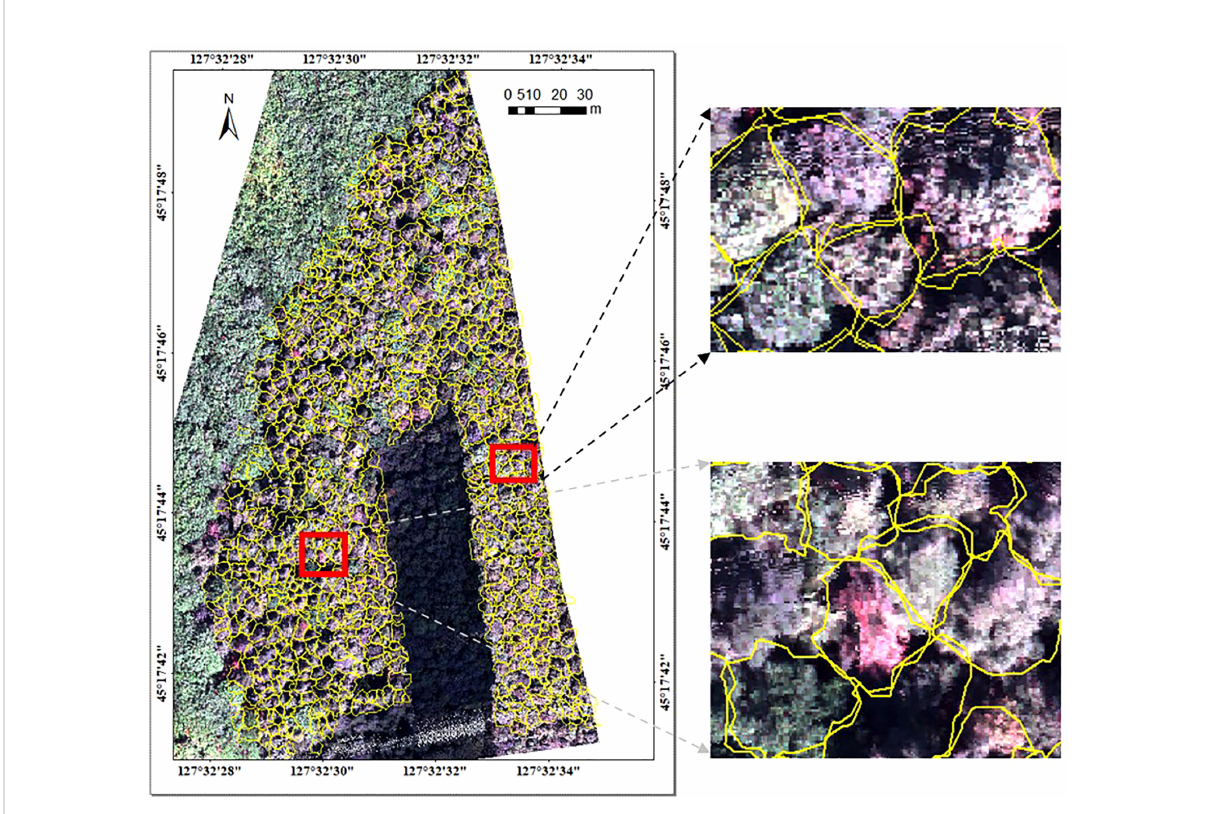
FIGURE 4 Segmentation results for hyperspectral image.